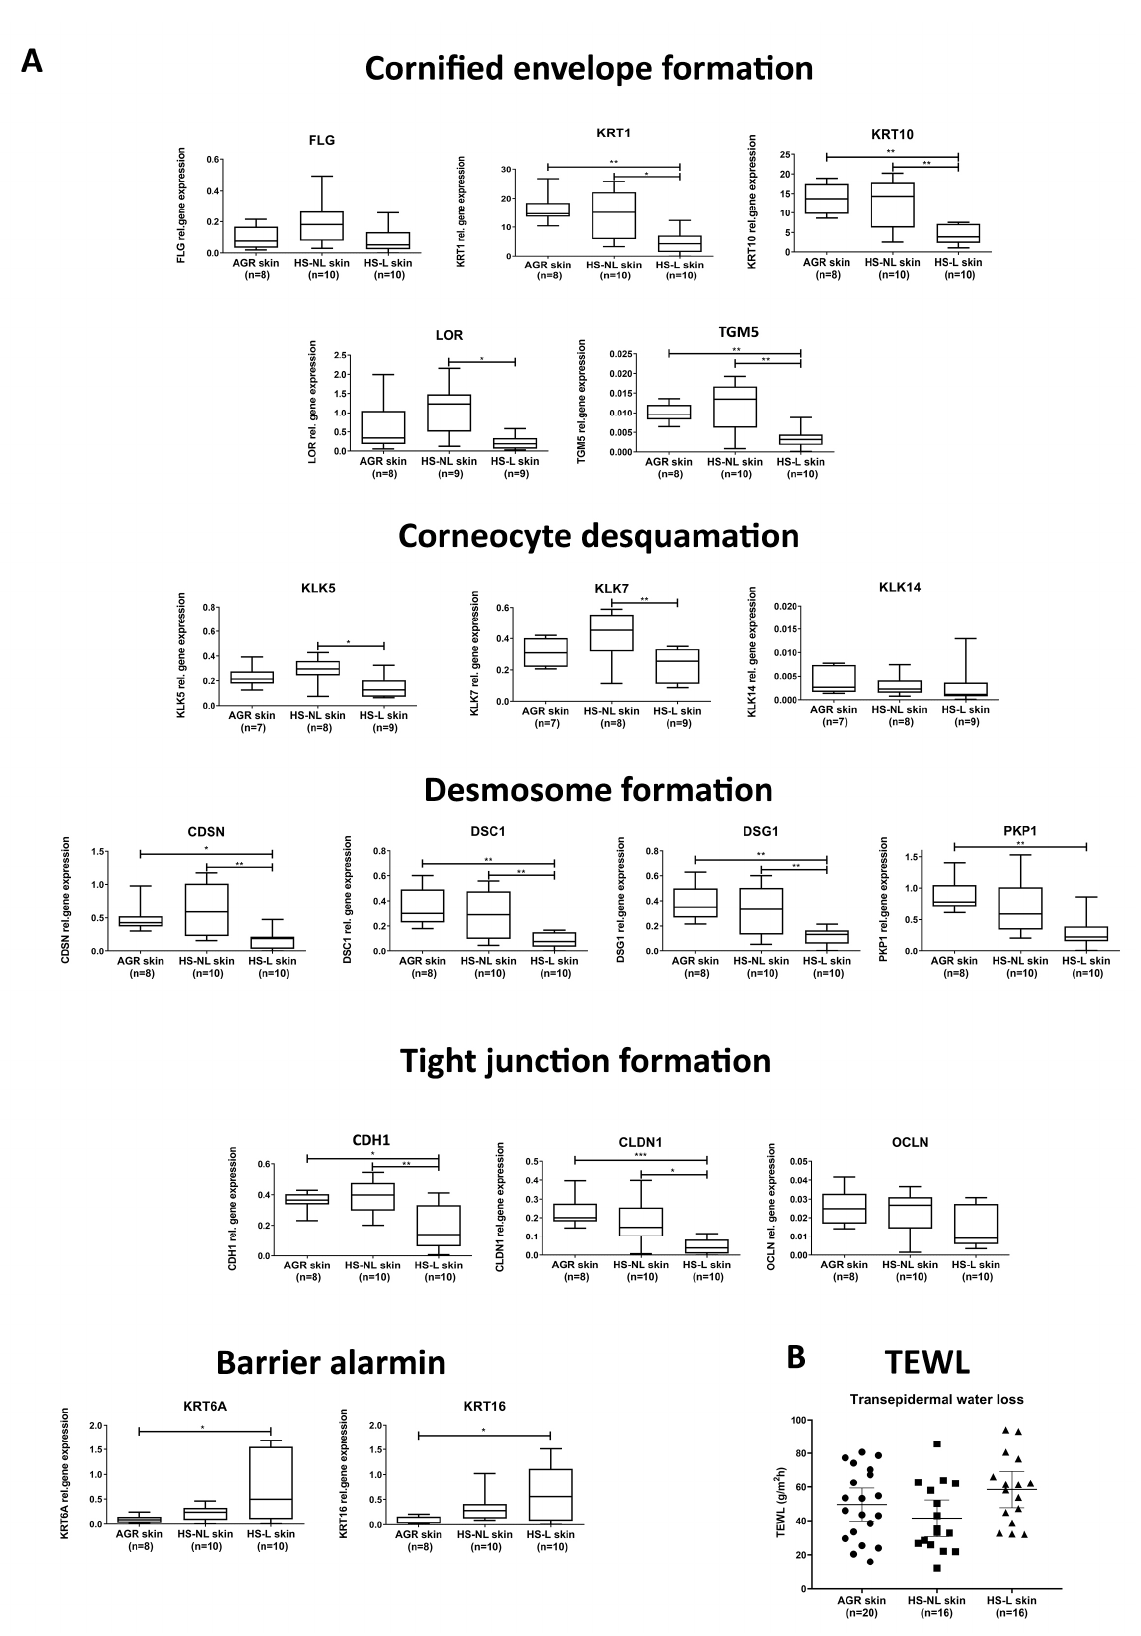
Figure 1. ( A ) Gene expression levels of permeability barrier components in healthy AGR, non-lesional HS and lesional HS skin examined with qRT-PCR. The graphs show the median ± 95% confi- dence interval of measured mRNA transcript levels (* p < 0.05; ** p < 0.01; *** p < 0.001, as determined by one-way analysis of variance followed by Sidak’s post hoc test in cases of normal distribution or Kruskal–Wallis test followed by Dunn’s post hoc test when data distribution was not normal).